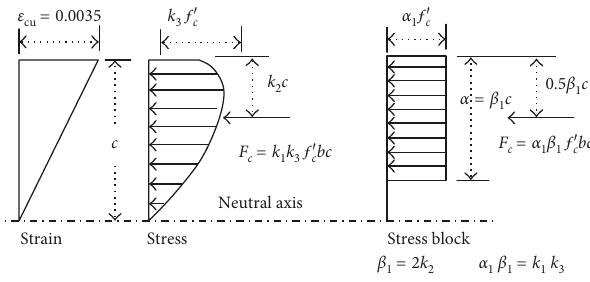
Figure 2: Equivalent rectangular compressive stress block (adopted from ACI 363R-92 [19] and ACI 318-08 [20]). Table 3: Estimated coefficients k 2 , k 1 , α 1 , and β 1 . Series Cylinder